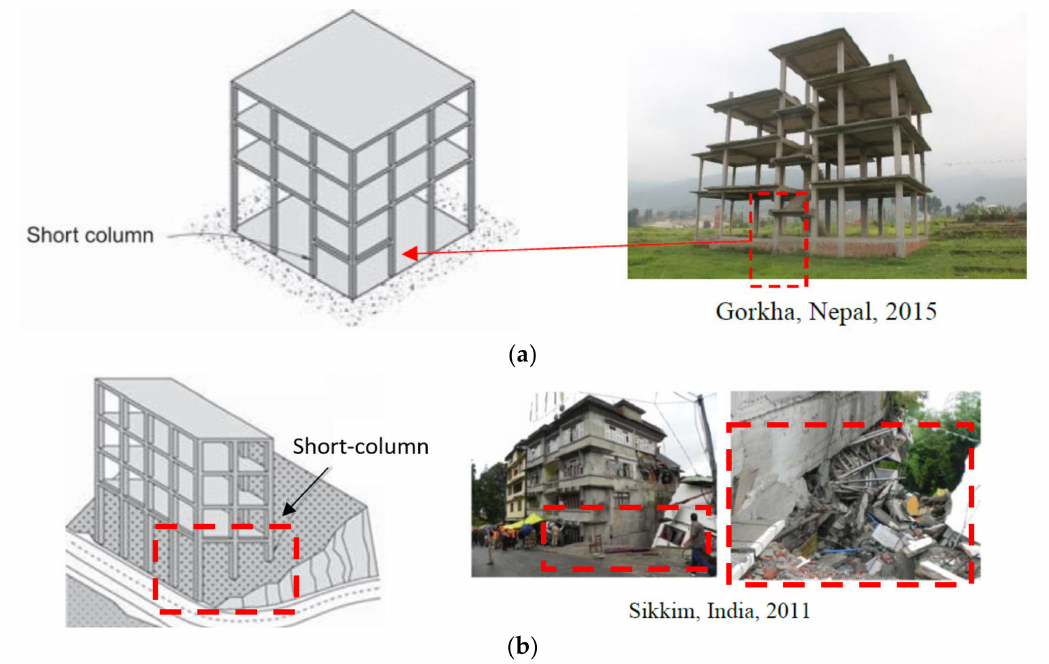
Figure 9. Damage type 6—example of post-earthquake damage in RC structures: short-column mechanism ( a ) due to the presence of beam (situation 1) and ( b ) due to a sloping site (situation